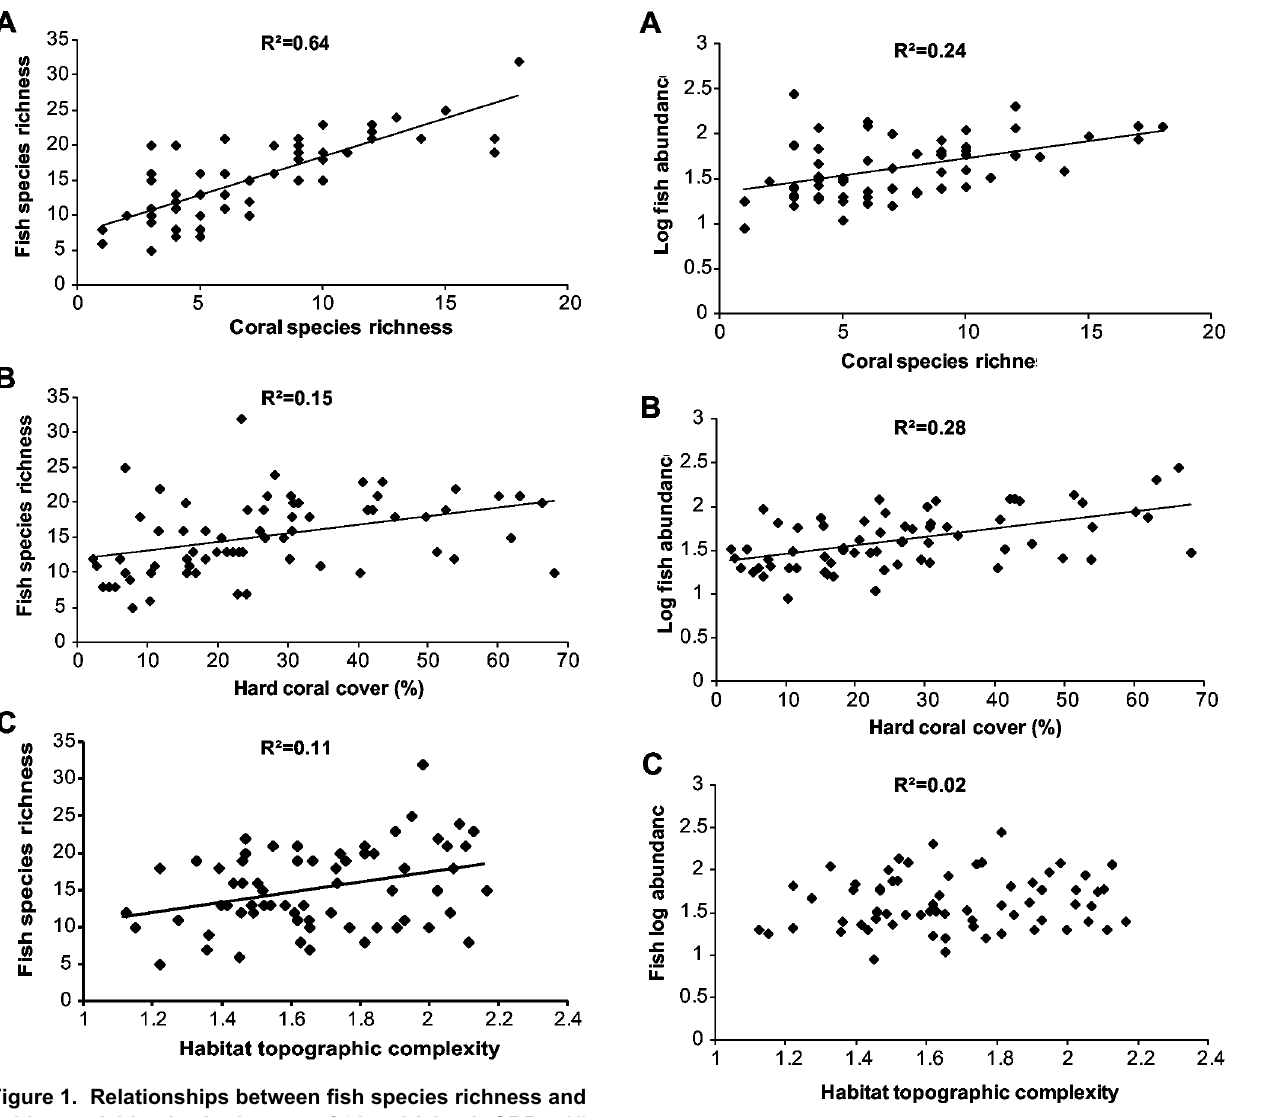
Figure 2. Relationships between log fish abundance and habitat variables in the lagoon of Lizard Island, GBR. Lines were only fitted to the statistically significant relationships (p<0.05). doi: